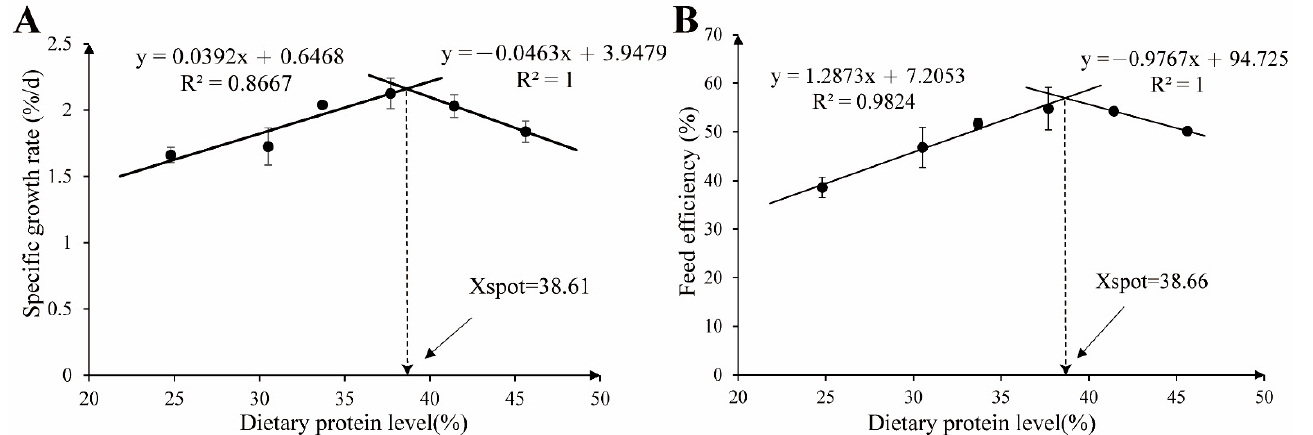
Figure 1. Broken-line analysis of the relationship between the dietary protein level and growth performance of grass carp. ( A ) The regression analysis between the specific growth rate and dietary protein level. ( B ) The regression analysis between the feed efficiency and dietary protein level. As shown in Table 4, the crude lipid content in the whole body increased linearly (R 2 = 0.375), while the muscle protein content increased first and then decreased in the quadratic model in response to the increasing protein level ( p < 0.05, R 2 = 0.331). No other significant difference in the proximate composition of the whole body and dorsal muscle was observed between treatments ( p >